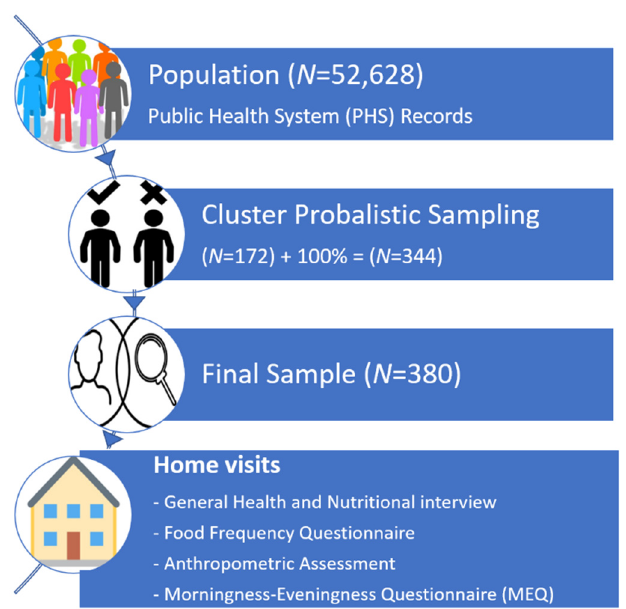
Figure 1. Fluxogram of study design. Creative Commons (CC) Licensing: “Association-community- group-meeting-152746” and “Search-people-selection-find-well-2831336” by OpenClipart- Vectors/27400 images and PaliGraficas, respectively, via Pixabay. Licensed under free for commercial use, no attribution required. “People selection” by B. Farias, CL, via thenounproject.com is licensed under CC 0. “House Emoji Icon” by “Twitter Emoji Follow” via iconscout.com is licensed under CC 0.